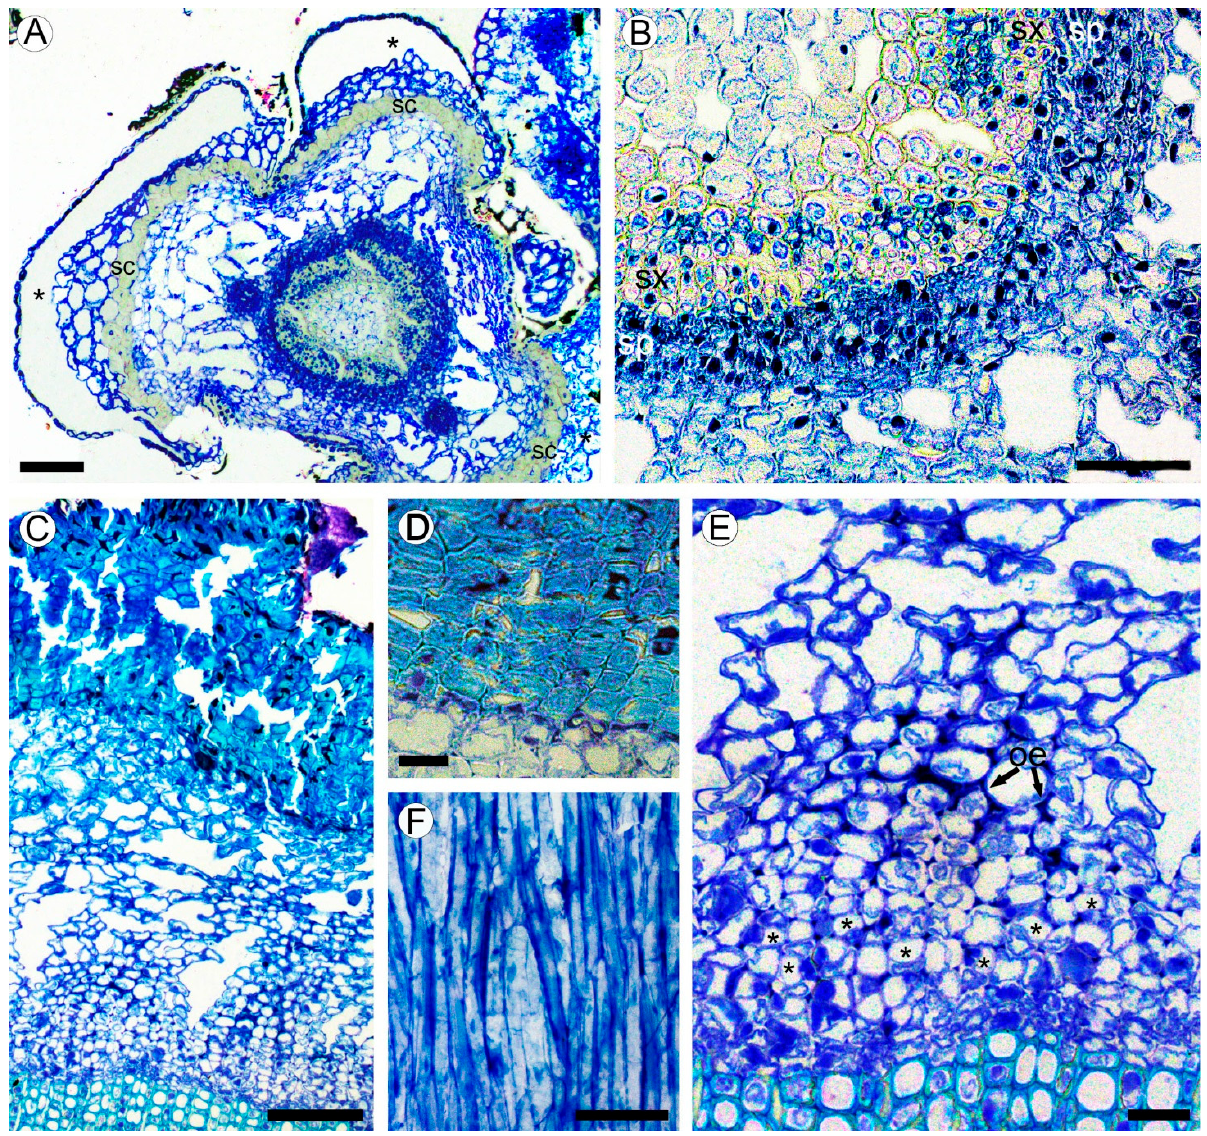
Figure 2. ( A , B ) Structure of young stem in Aragoa corrugatifolia (LM). ( A ) Young shoot with prominent leaf bases in the lower portion of fourth elongated internode (TS), vascular cambium with juvenile rings of secondary xylem and secondary phloem, cortical aerenchyma, leaf bases (asterisks) outlined with the bands of sclereids (sc); ( B ) portion of the ring of secondary conductive tissues shown in Figure 2A (TS), continuous rings of secondary xylem (sx) and secondary phloem (sp). ( C – F ) Structure of mature bark. ( C ) Secondary phloem, cortex with aerenchyma, periderm with uniseriate phelloderm, and prominent phellem made of thick-walled cell (TS); ( D ) Portion of periderm, phellem cells with thick sclerified walls, thin-walled phelloderm cells in one to two layers (TS); ( E ) portion of secondary phloem and cortical aerenchyma shown in Figure 2C (TS), sieve tubes with companion cells in radial groups (*), obliterated phloem elements (oe), large intercellular spaces in cortex; ( F ) tangential longitudinal section (TLS) of secondary phloem; strands of phloem axial parenchyma, lack of rays. Scale bars: 100 µm for ( A , C ), 50 µm for ( B , F ), 20 µm for ( D , E ).